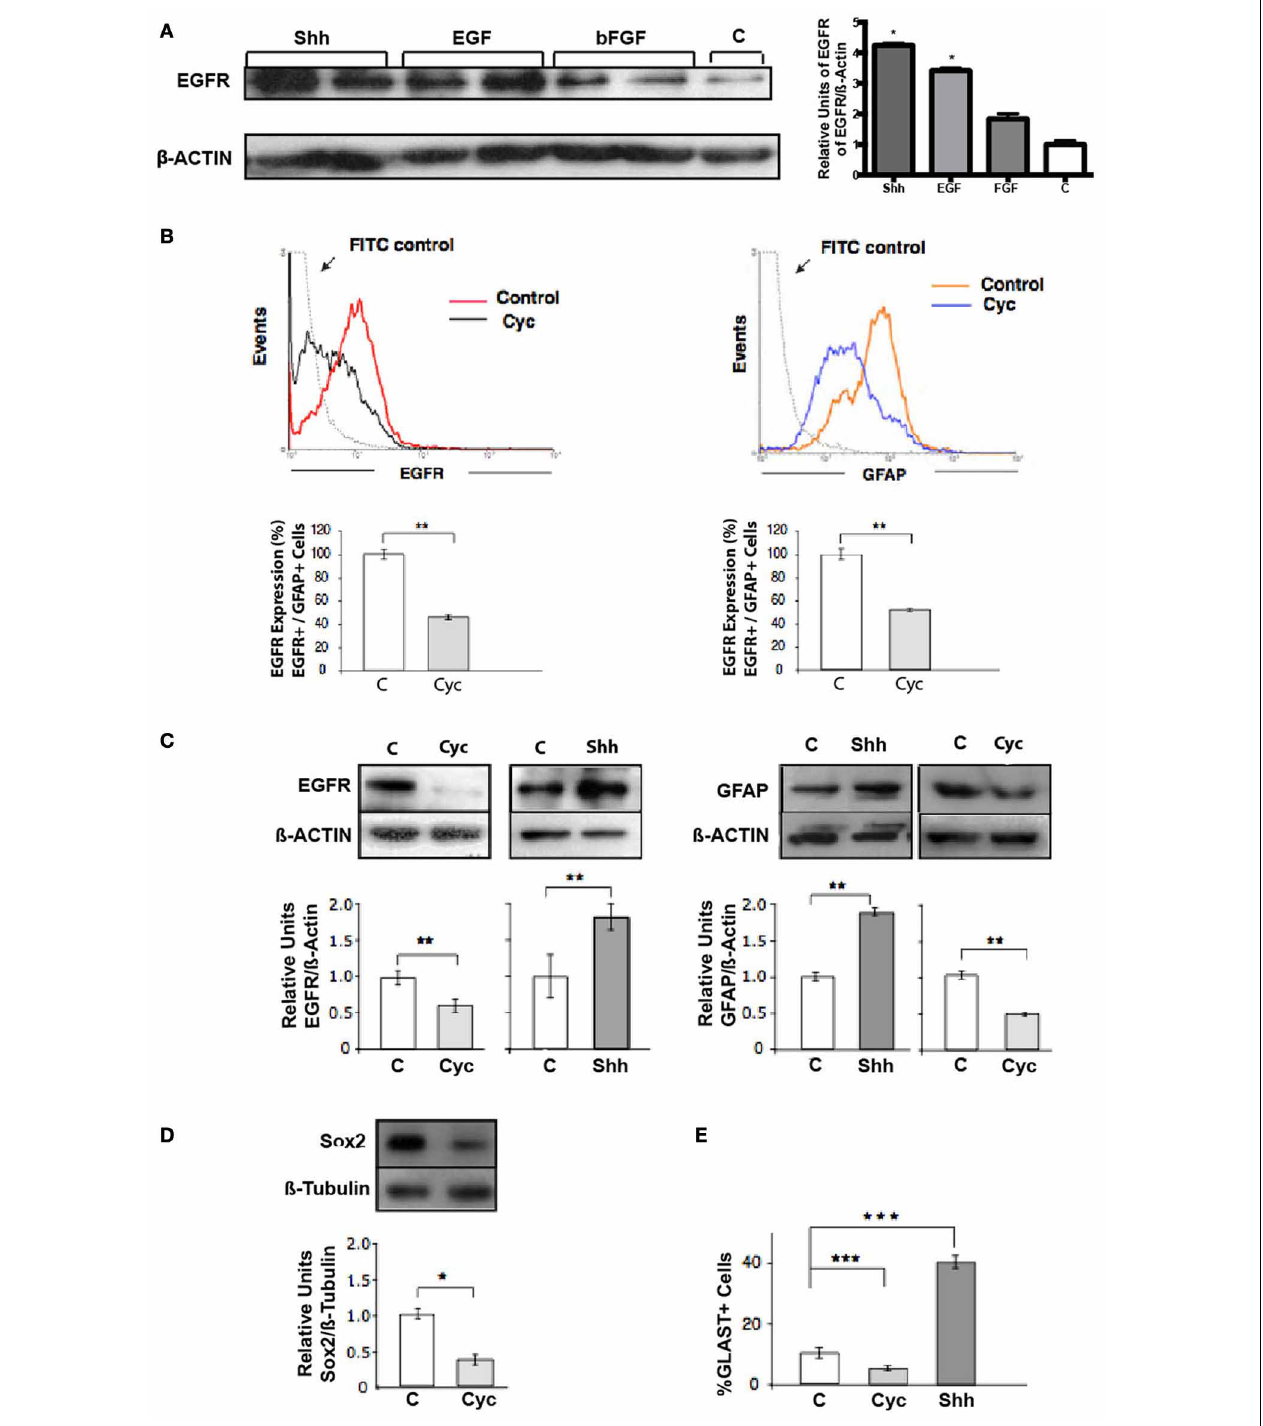
FIGURE 2 | Shh controls the pool of RG cells (GFAP + , Sox2 + , GLAST + ) that express EGFR. (A) Western blot and densitometry analysis of EGFR show higher levels of EGFR in Shh-treated explants in comparison to samples treated with bFGF and positive control EGF. (B) Flow cytometry of cells harvested from E18.5 cortical explants. Treatment for 48h with Cyc (10 μ M) provokes similar decreases in the pool of EGFR- and GFAP-expressing cells. Histograms are representative of three independent experiments expressed